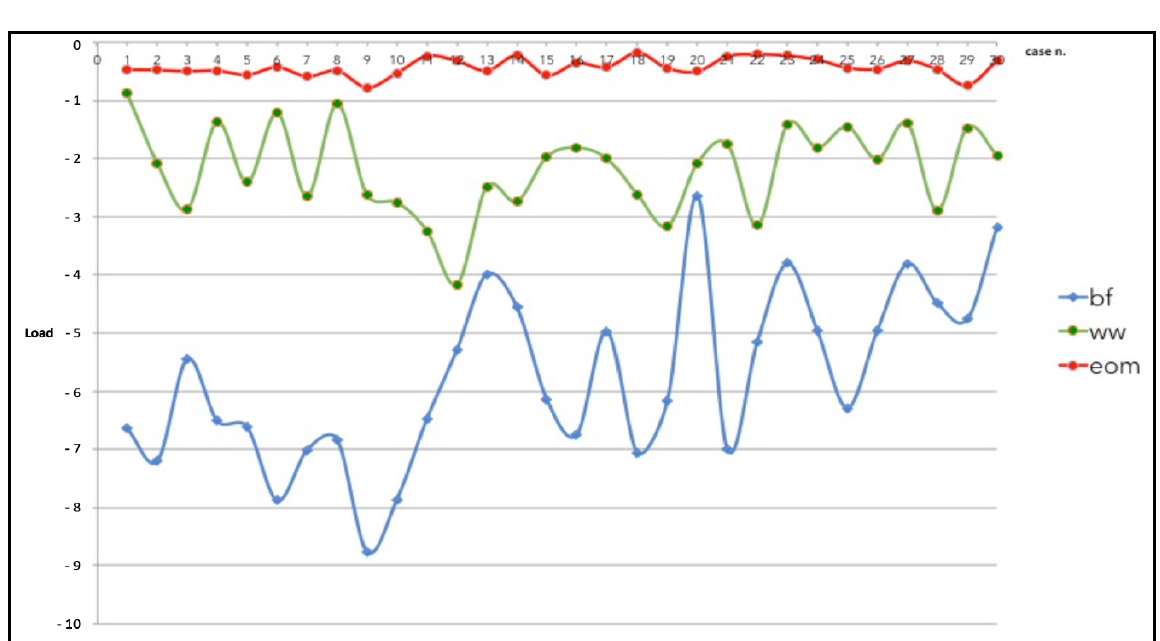
Figure 10. Comparison among the highest compressive loads of the balanced forces (BF) technique, watch winding (WW) motion, and the envelope of motion (EOM) in the thirty models. Figure 11 shows the estimated prediction means of the three techniques WW, BF, and EOM by the highest and lowest compressive loads with 95%